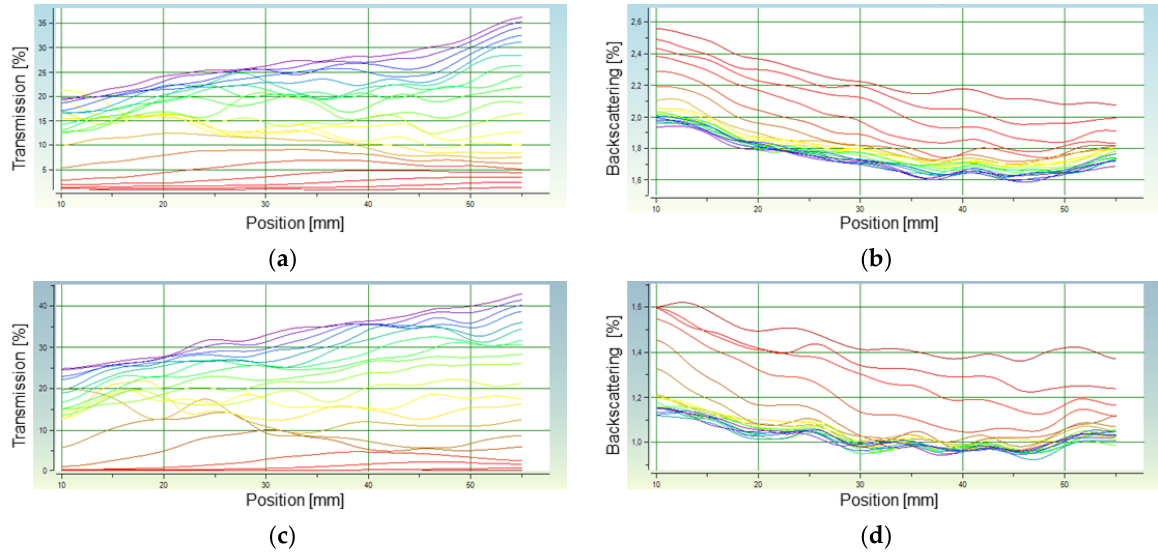
Figure 9. Analysis of the stability of the HAp A and HAp B suspensions in distilled water: ( a ) transmission of HAp A; ( b ) backscattering of HAp A; ( c ) transmission of HAp B; ( d ) backscattering of HAp B.